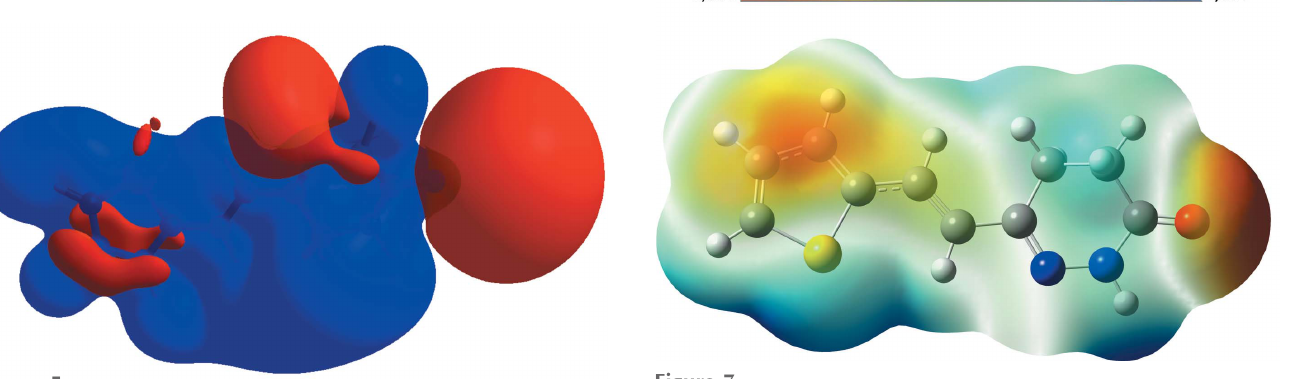
Figure 5 A view of the molecular electrostatic potential for the title compound in the range (cid:5) 0.084 to 0.084 a.u. generated by DFT using the 6–31G(d,p) basis set.